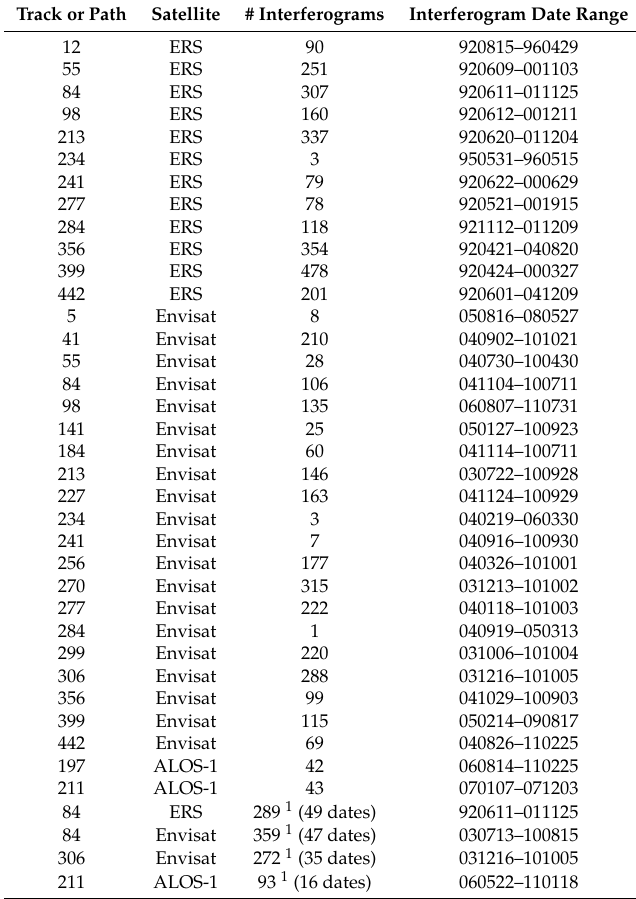
Table 1. Tracks and paths of InSAR data from the different satellites in the western USA with the time span of each listed (format YYMMDD). Most of the tracks from ERS and Envisat are plotted in Figure 1 and all have multiple frames per track. Information on number of interferograms used in the time series from different tracks and paths are listed. 1 East Mesa. InSAR: interferometric synthetic-aperture radar; ERS: European Remote Sensing; ALOS: Advanced Land Observing